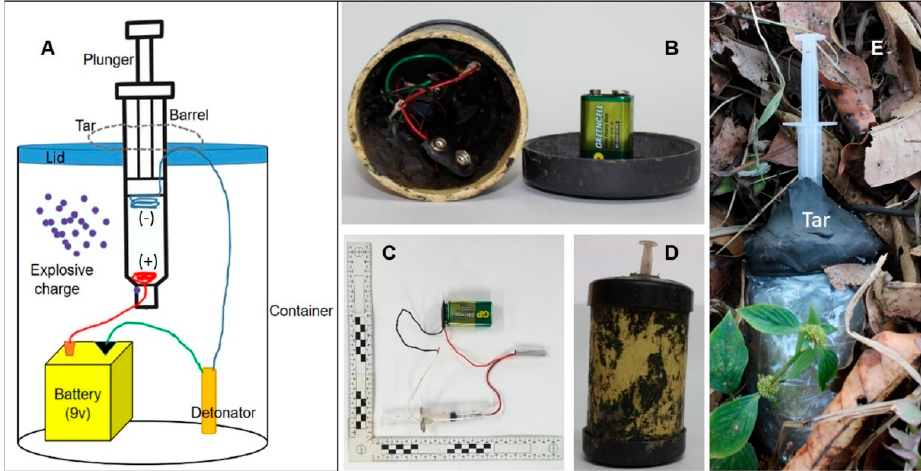
Figure 1. ( A ) Design of the homemade explosive device used in the study and layout of its components; ( B ) Internal arrangement of the device without the explosive charge and power source not connected; ( C ) Connection between the electrical circuit, power source and fuse; ( D ) The explosive device before activation and sealing; ( E ) Complete assembly of the waterproofed homemade AP landmine.